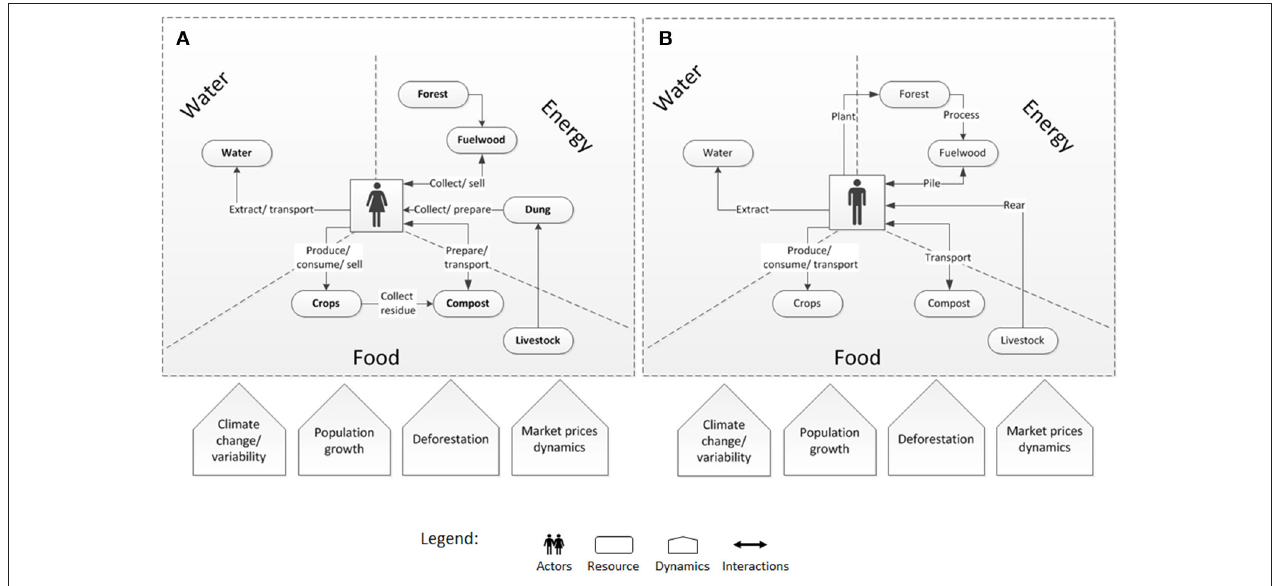
FIGURE 3 | Simplified conceptual frameworks of the local WEF nexus system according to (A) female-only and (B) male-only